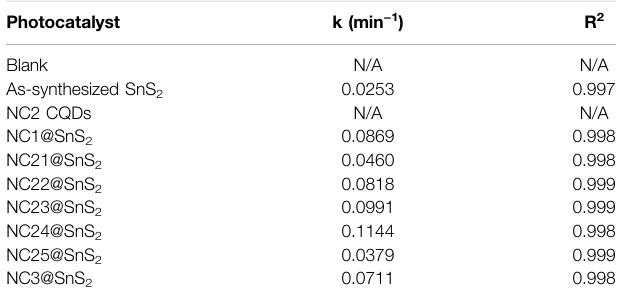
TABLE 1 | Fitting parameters of the following photocatalysts: blank, NC2 CQDs, as-synthesized SnS 2 nanoparticles, and NC@SnS 2 samples.